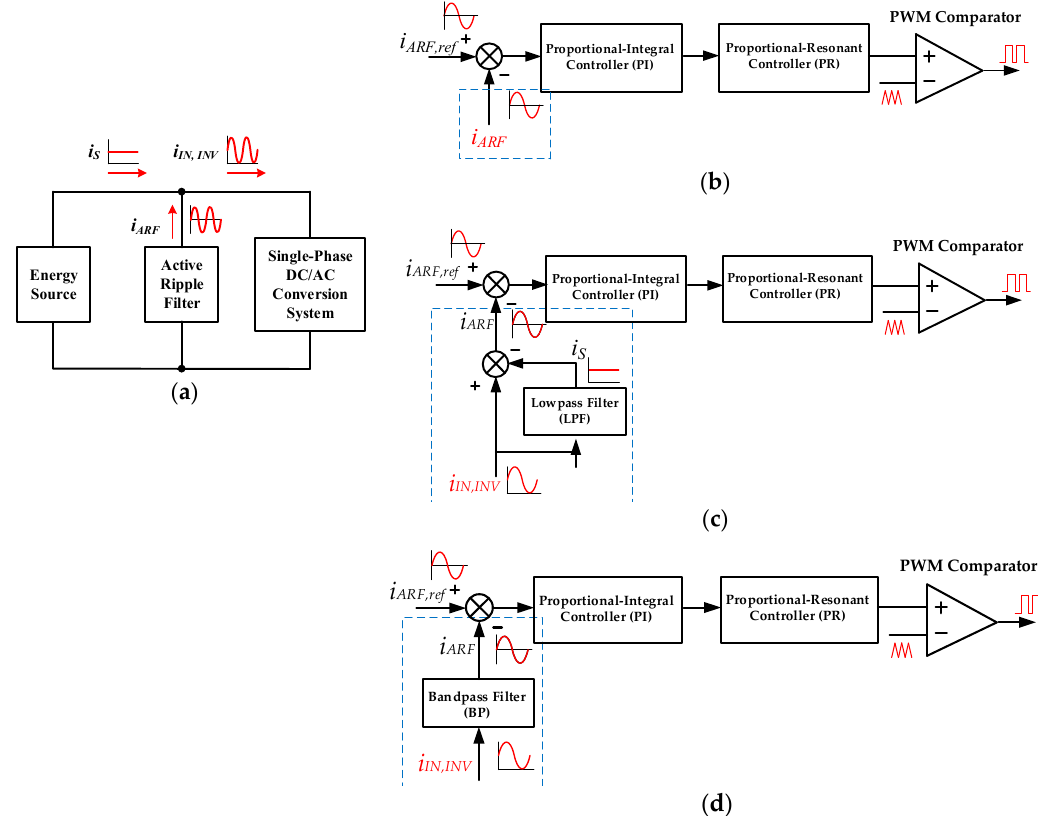
Figure 1. The general ARF scheme ( a ); and its conventional control diagrams (b, c,d ) for the single-phase DC/AC conversion system applications.